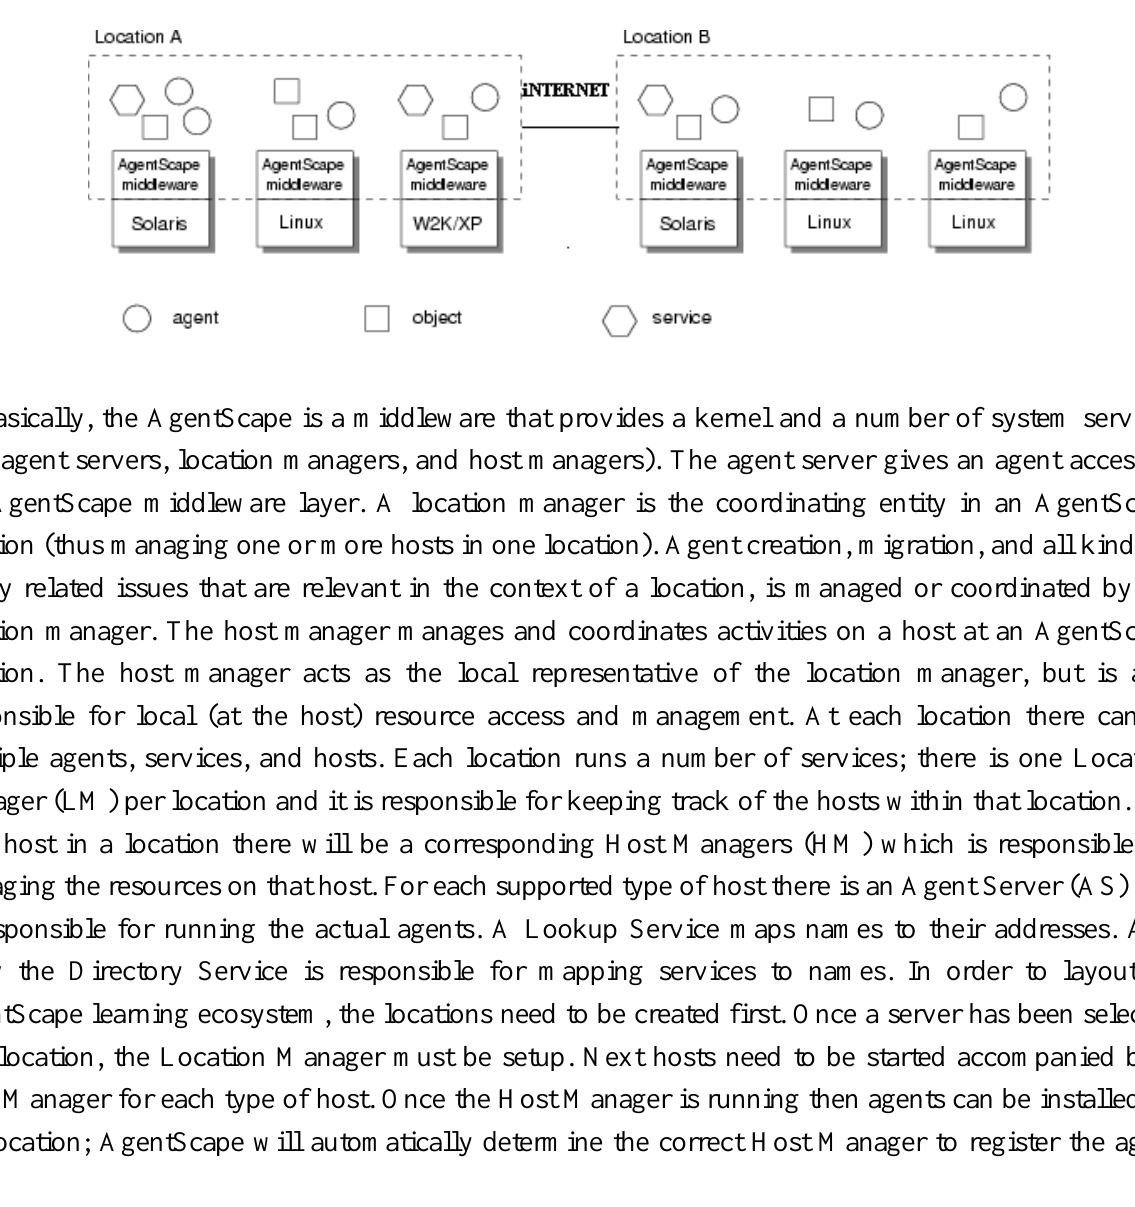
Figure 7. AgentScape Interoperability